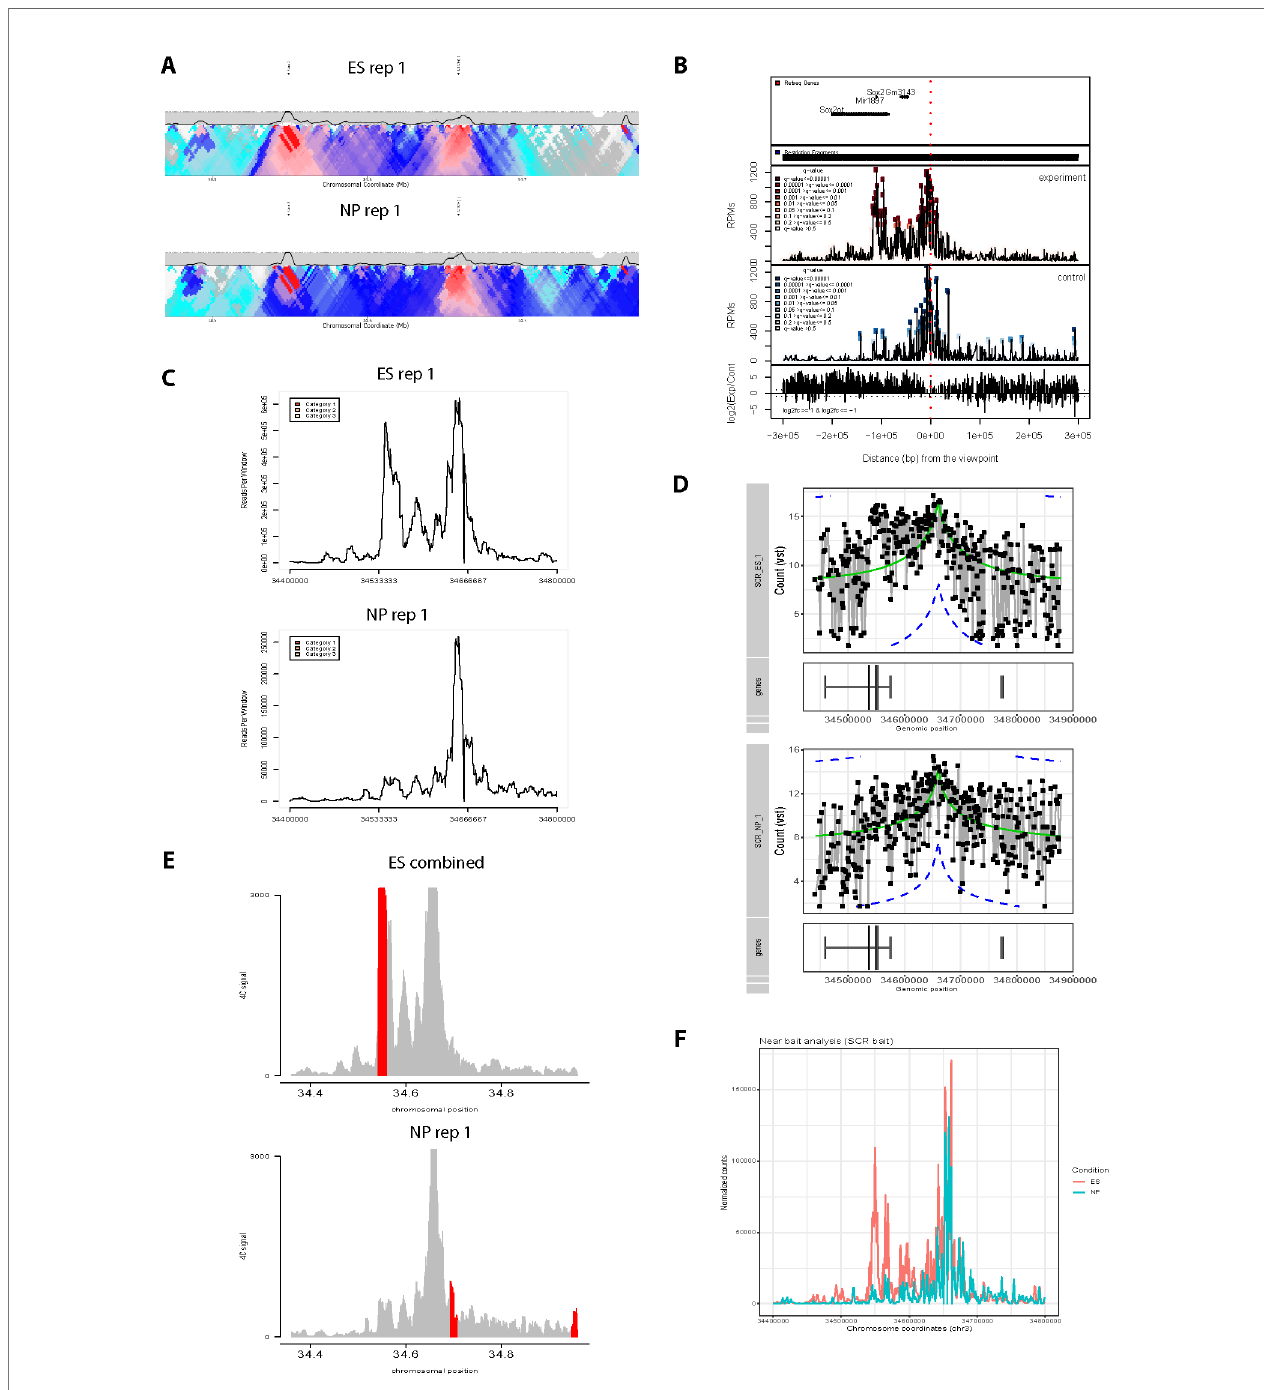
FIGURE 2 | Overview of graphing options from existing 4C analysis methods. All methods have been applied to two ES replicates and one NPC 4C data set for the Sox2 SCR bait (see also Figure 3 ). (A) 4Cseqpipe (van de Werken et al., 2012) results shown independently for one ES replicate and the NPC data set. Running median scores are plotted as a line graph (5 kb resolution), with domainograms plotted underneath as a heat map for median scores at steadily increasing window sizes. Positions of the CTCF site within the SCR and the Sox2 gene are indicated by arrows. Note that the independent normalization means that the SCR- Sox2 interaction differences between the two cell types is not evident, compared to other methods. (B) r3Cseq (Thongjuea et al., 2013) results for the combined three data sets, showing panels, from top to bottom: positions of Refseq genes; restriction fragment coverage; averaged pro fi le for the “ experiment ” (ES) condition, with called interactions at different con fi dence levels highlighted; pro fi le for the “ control ” (NPC) condition, with called interactions at different con fi dence levels highlighted; plot of the log2-ratio of experiment vs control 4C signal. The position of the SCR bait is indicated by a red dashed line. Note that r3Cseq appears to call a very large number